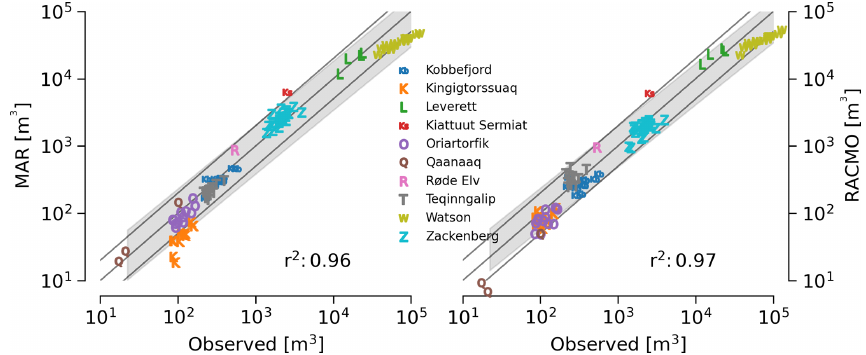
Figure 4. Bulk observation vs. RCM scatter plots. Similar to Fig. 3, except here showing annual sum of observed runoff – all days within each year when observations exist are summed. Days without observation are excluded from this comparison. Solid lines show 1 : 1 (center), 1 : 2 (upper), and 2 : 1 (lower). Grey band shows 5% to 95% prediction